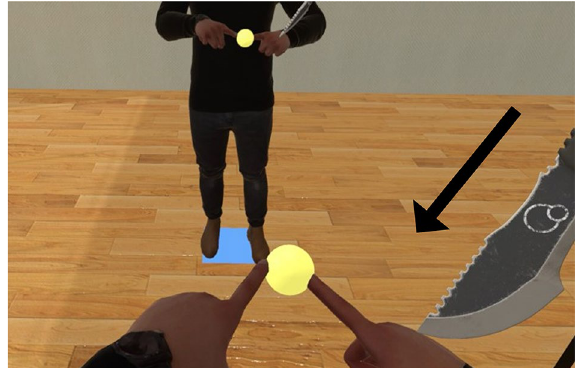
Figure 3. Stimulus of the knife at the end of the reaching task: example scene of the joint avatar’s right hand being stabbed at the end of the Same goal